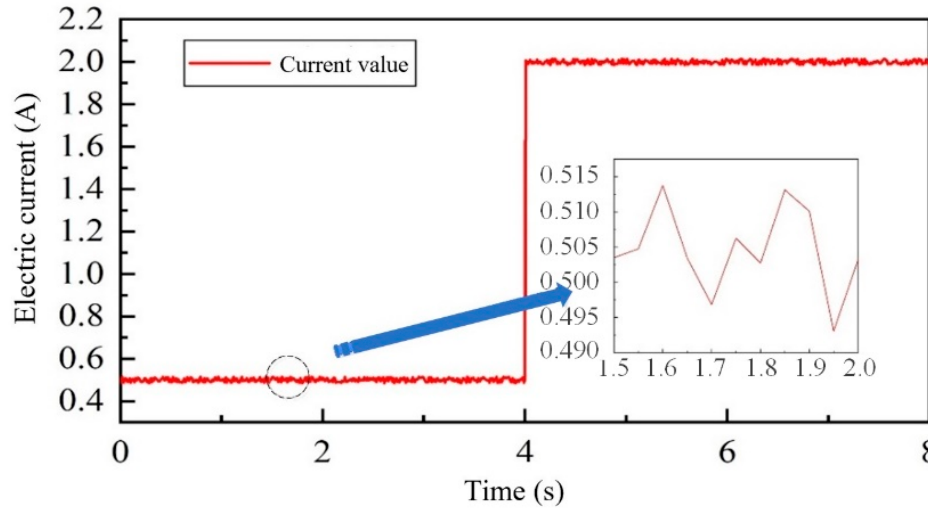
Figure 18. Control output for programmable current source.